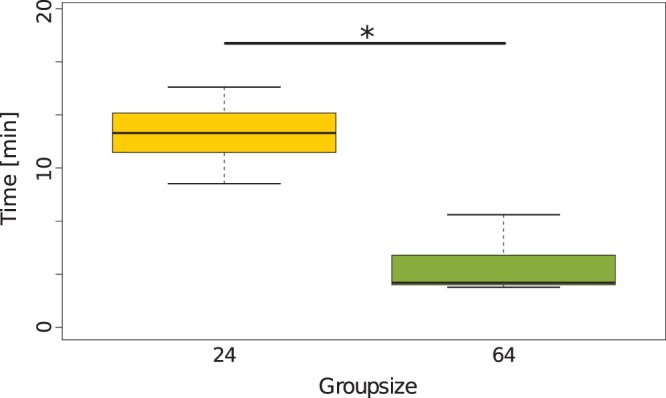
Speed of the decision making.The graph shows the time in minutes (median and quartiles) until the minimum number of bees for a statistically significant decision was reached (p<0.05, MannWhitney U test). The data include trials with 24 and 64 bees.